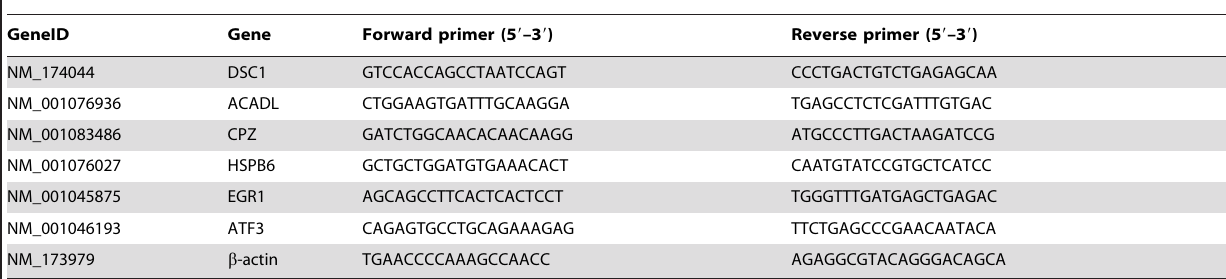
Table 1. List of primers used in qPCR